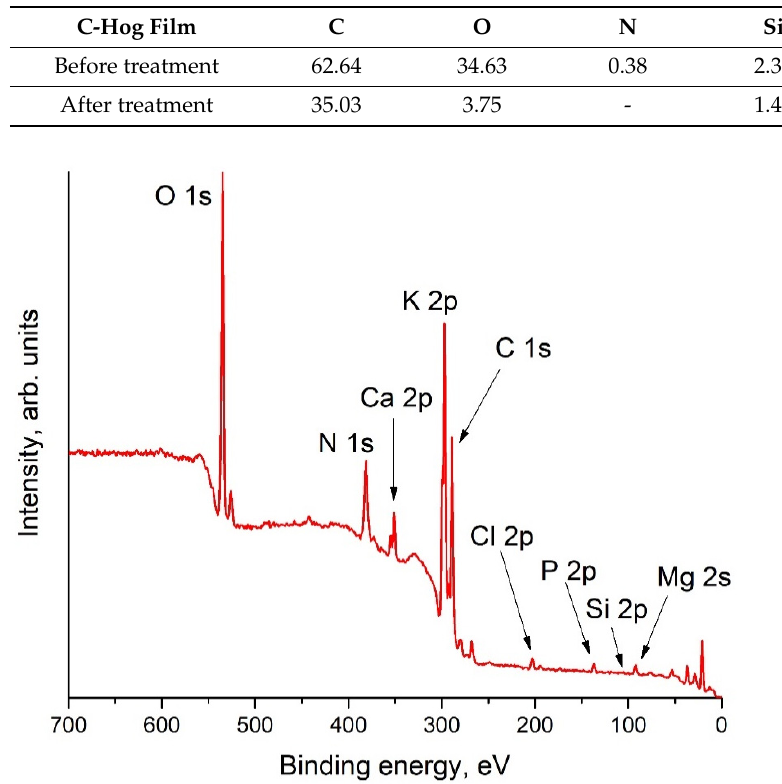
Figure 6. Survey XPS spectrum of ash obtained by burning hogweed in air. Table 7. Composition of the hogweed ash (in at %) determined from XPS.